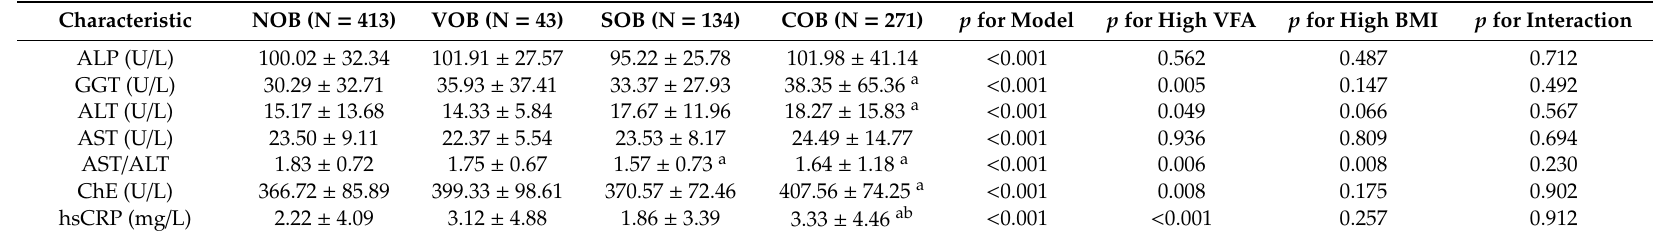
Table 5. Associations among high BMI, high VFA, and metabolic risk factors of